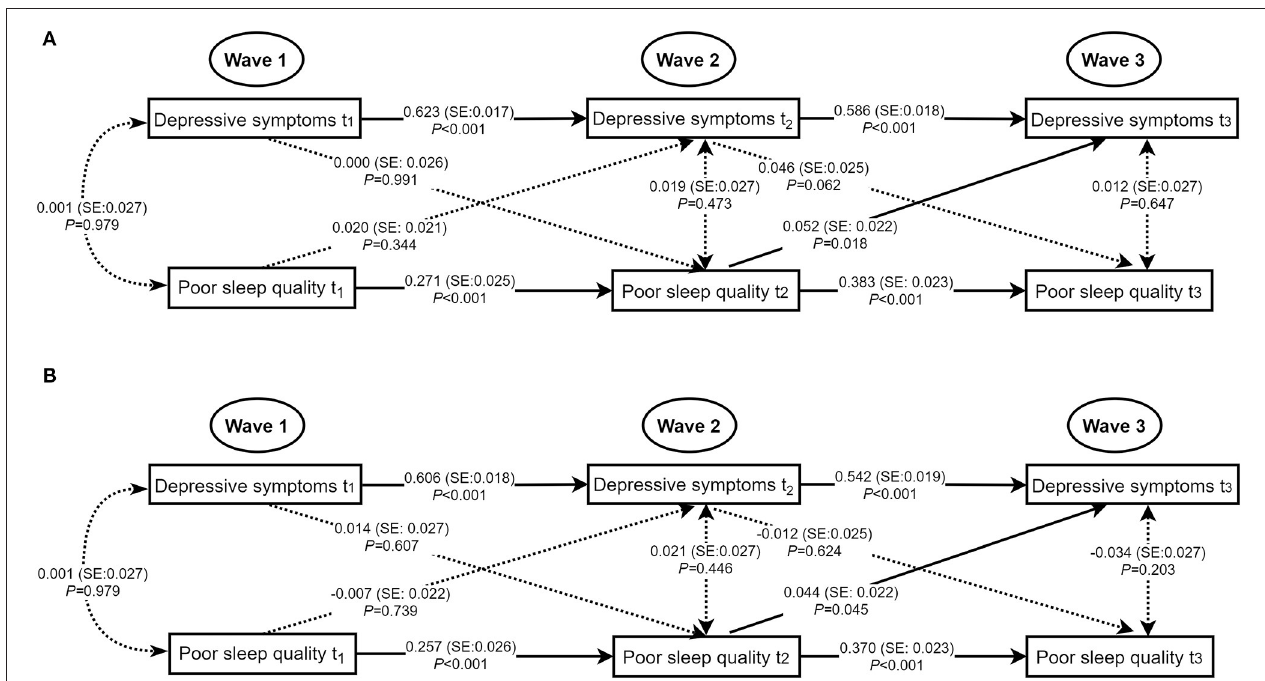
FIGURE 2 | Concurrent and cross-lagged associations between poor sleep quality and depressive symptoms. (A) Unadjusted models. (B) Models adjusting for age, sex, living arrangement, family relations, student-teacher relations, ever smoking, and ever drinking; for clarity of presentation, the standardized coefficients of the control variables were not displayed in the model but were included in the analyses. SE, standard error; the solid line meant the standardized coefficient was statistically